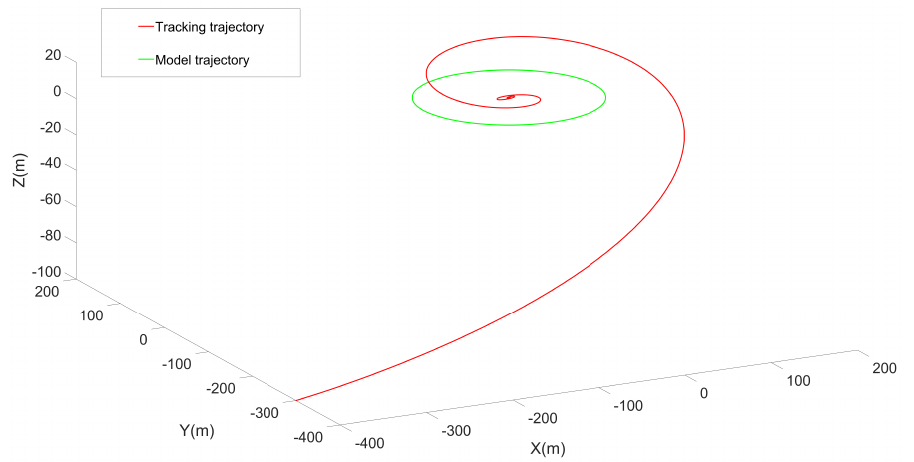
Figure 7. Trajectory without the feedforward